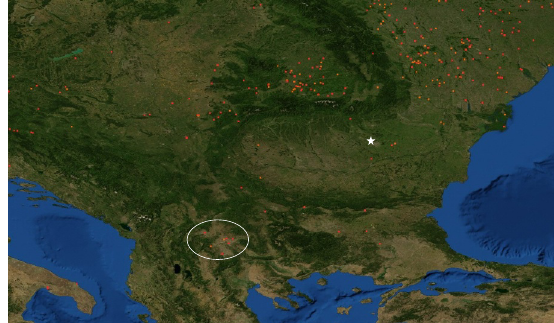
Fig. 4. Screenshot of the fires seen by MODIS 48h before the event run by Hysplit. The star shows INOE location and the eclipse shows the region with fires along